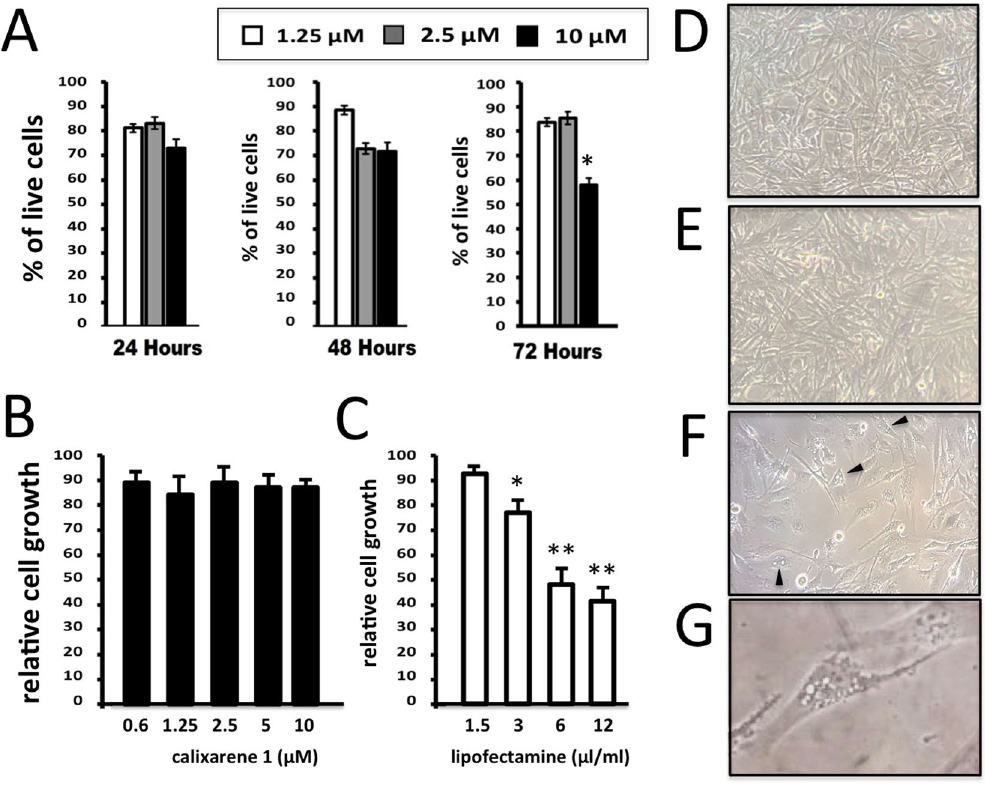
Figure 2. Effects of calixarene 1 on viability, cell proliferation and morphology of U251 cells. ( A ) Viability profile in U251 cells was reported for three incremental concentrations of 1 : 1.25 µ M (white bars), 2.5 µ M (grey bars) and 10 µ M (black bars). Three different time points: 24, 48 and 72 hours after the transfection were considered. ( B – G ) Comparison between the effects of calixarene 1 ( B , E ) and Lipofectamine RNAiMAX ( C , F , G ) on U251 cell growth ( B , C ) and morphology ( D – G ), determined after 72 hours cell culture. D = control untreated U251 cells. Appearance of vacuolization and methuosis-like patterns are underlined by the arrowheads shown in panel F (representative example in the panel